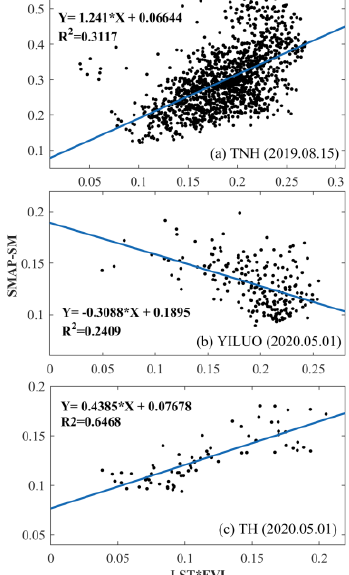
Figure 4. The polynomial regression relationships established for the three test areas — TNH (short for Tangnaihai River basin), YILUO (short for Yiluo River basin), and TH (short for Tanghe River